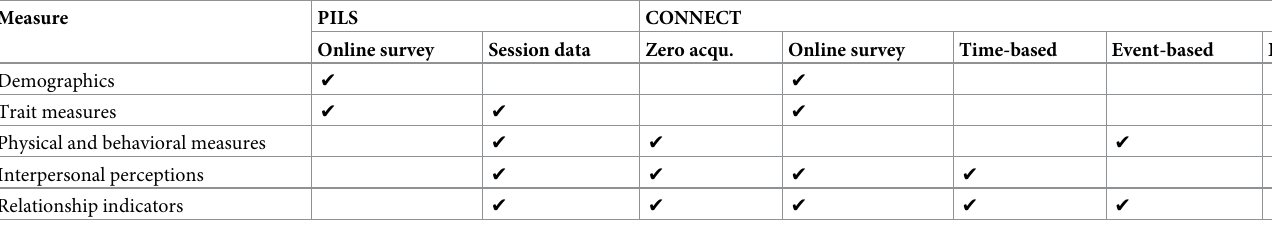
Table 1. Overview of variable groups and data sources in PILS and CONNECT.